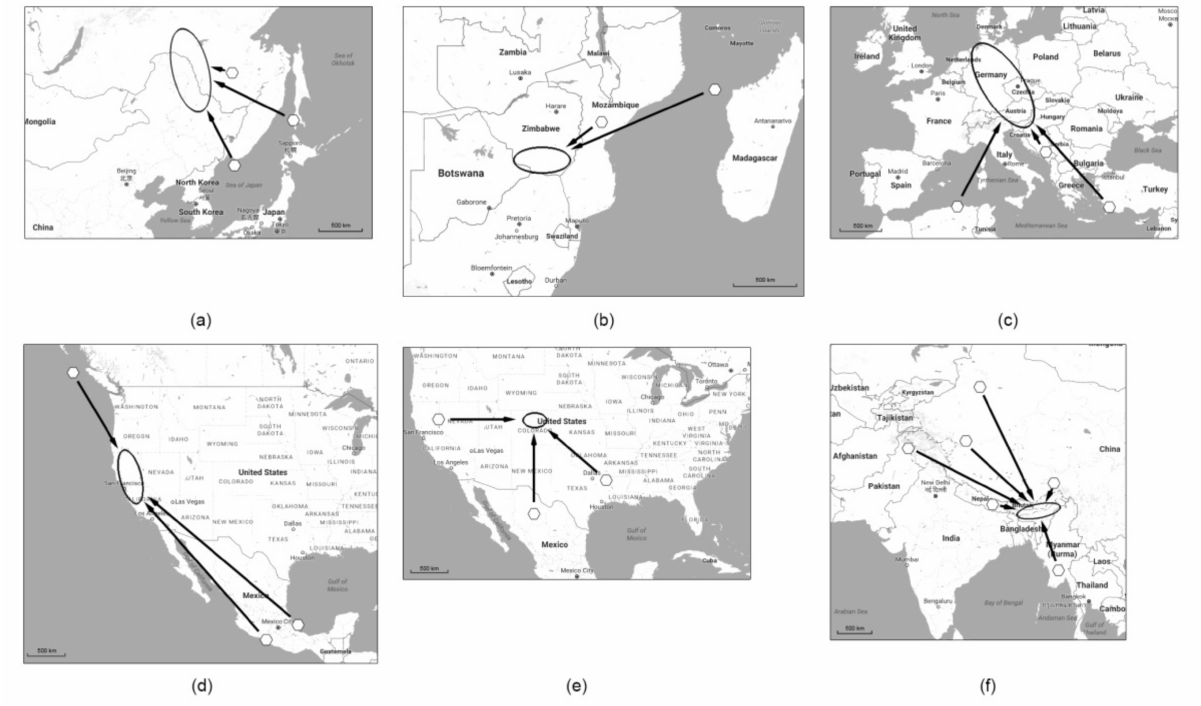
Figure 16. Relative positions of groups of earthquake epicenters regarding the flooding area: ( a , b )— one-directional arrangement; ( c , d )—two-directional arrangement; ( e , f )—multi-directional arrange- ment. White hexagons—the earthquakes epicenters; black ovals–the flooding